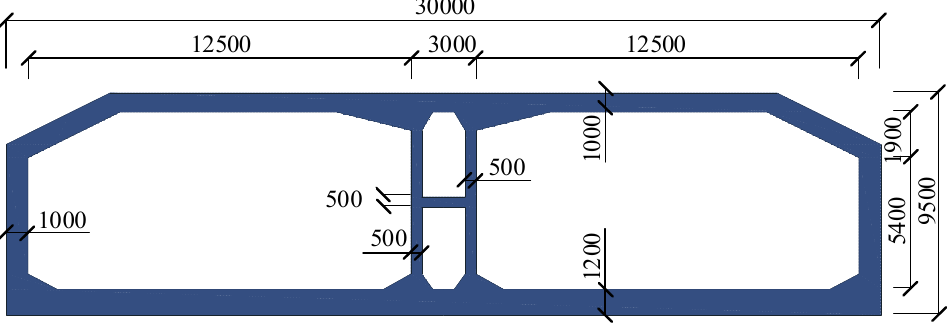
Figure 5. The main section dimensions of an immersed tube tunnel (mm).